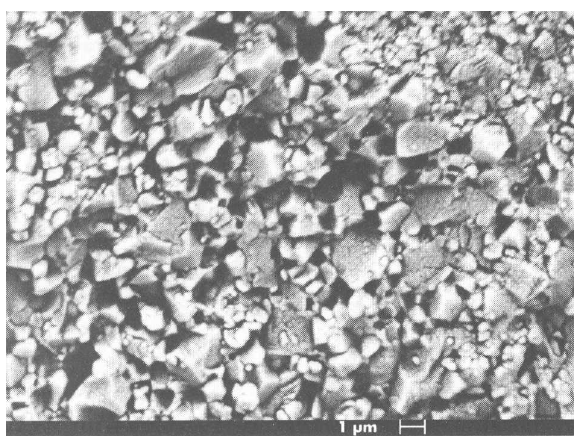
Figure 2. Fracture surface of SSiC, SEM.